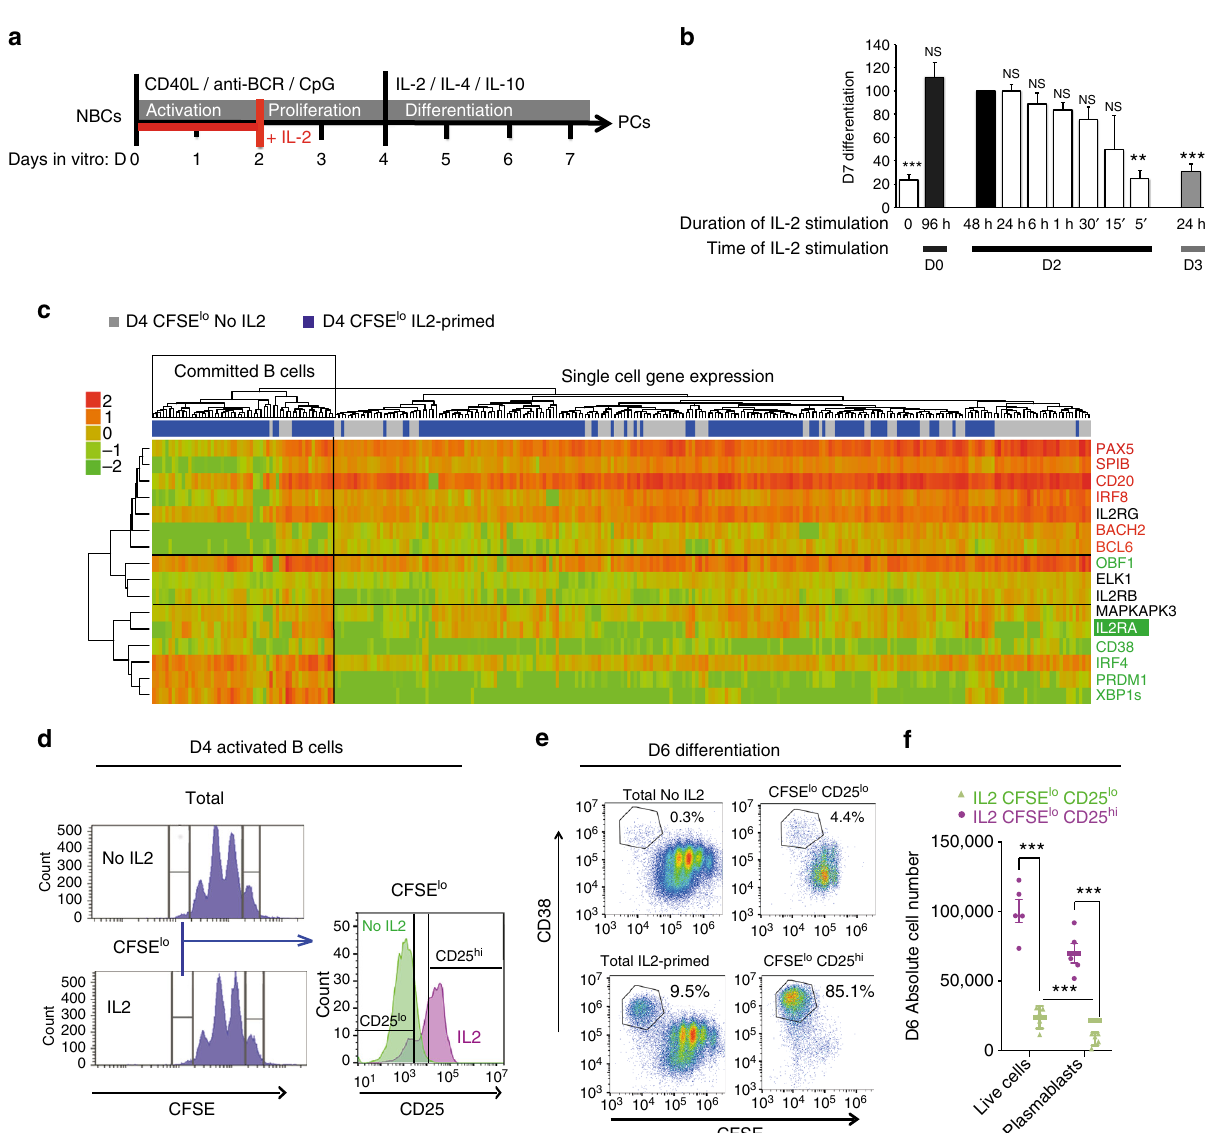
Fig. 1 A minimal early and transient IL-2 signal confers plasma cell differentiation ability to human naive B cells. a Experimental design to differentiate primary naive B cells (NBCs) into plasma cells (PCs). Activation of peripheral blood mature naive B cells was initiated by BCR cross-linking (anti-BCR), CpG and CD40L during 4 days followed by cell washing and induction of terminal differentiation into plasma cells with IL-2, IL-4 and IL-10 over 3 days. Antigen-primed naive B cells have 2-day window (in red) for acquisition of early T cell help in the form of IL-2 which is required to recruit B cells into the plasma cell differentiation program. b Kinetic experiments of IL-2 stimulation to determine the time window (in day, D) and the minimal duration (in hours, h) for B cell to acquire differentiation ability. IL-2 was added in the medium at the indicated day. Neutralising antibodies against IL-2 or IL2 receptors were used to block IL-2 signalling and isotype antibodies were used as controls. Results are the mean of plasma cell numbers with the s.d. quanti fi ed at D7 by fl ow cytometry and fi xed to 100 for the condition corresponding to 48 h of IL-2 stimulation (black bar) to normalise between experiments ( n = 5). c Single-cell QRT-PCR analysis in the D4-CFSE lo subset of cells that were primed with IL-2 (in blue, n = 175) or not (in grey, n = 110) at D2. The heatmap shows the spectrum of normalised Ct values with a global Z -score: red indicates high level of expression and green indicates low level of expression. Non- hierarchical clustering corresponding to 16 selected genes is shown. Two clusters of cells can be identi fi ed with on the left the nascent fraction of plasma cell progenitors showing induced plasma cell transcription factors expression in green linked to an IL-2 signature ( IL2RA expression), concomitant with B cell factors repression in red. d Heterogeneity of CD25 (IL2RA) expression analysed by fl ow cytometry in the D4-CFSE lo subset of cells. Cell division visualised by CFSE dilution at D4 is similar in IL-2 treated and non-treated cells (IL2 and No IL2, respectively). Among CFSE lo cells, CD25 was upregulated in a subset of cells that were cultured in presence of IL-2 (CD25 hi ). e IL-2-primed cells, sorted at D4 based on CFSE dilution and CD25 expression from gates in d , were put back in culture to assess differentiation into plasma cells (CFSE lo CD38 hi ) monitored by fl ow cytometry at D6, in comparison with their non-sorted counterpart (Total IL2-primed) and the control cells cultured without IL-2 (Total No IL2). One experiment representative of 5 is shown. f Absolute numbers of DAPI negative cells (Live cells) and CFSE lo CD38 hi plasmablasts generated from 10 5 CFSE lo CD25 lo cells (in green) or CFSE lo CD25 hi cells (in purple) sorted at D4 from gates in d , and put back in culture for 2 more days (mean ± s.e.m, n = 5). For experiments shown in b and f , * p < 0.05, ** p < 0.01, *** p < 0.005, NS: No signi fi cant differences, two-tailed unpaired Student ’ s t